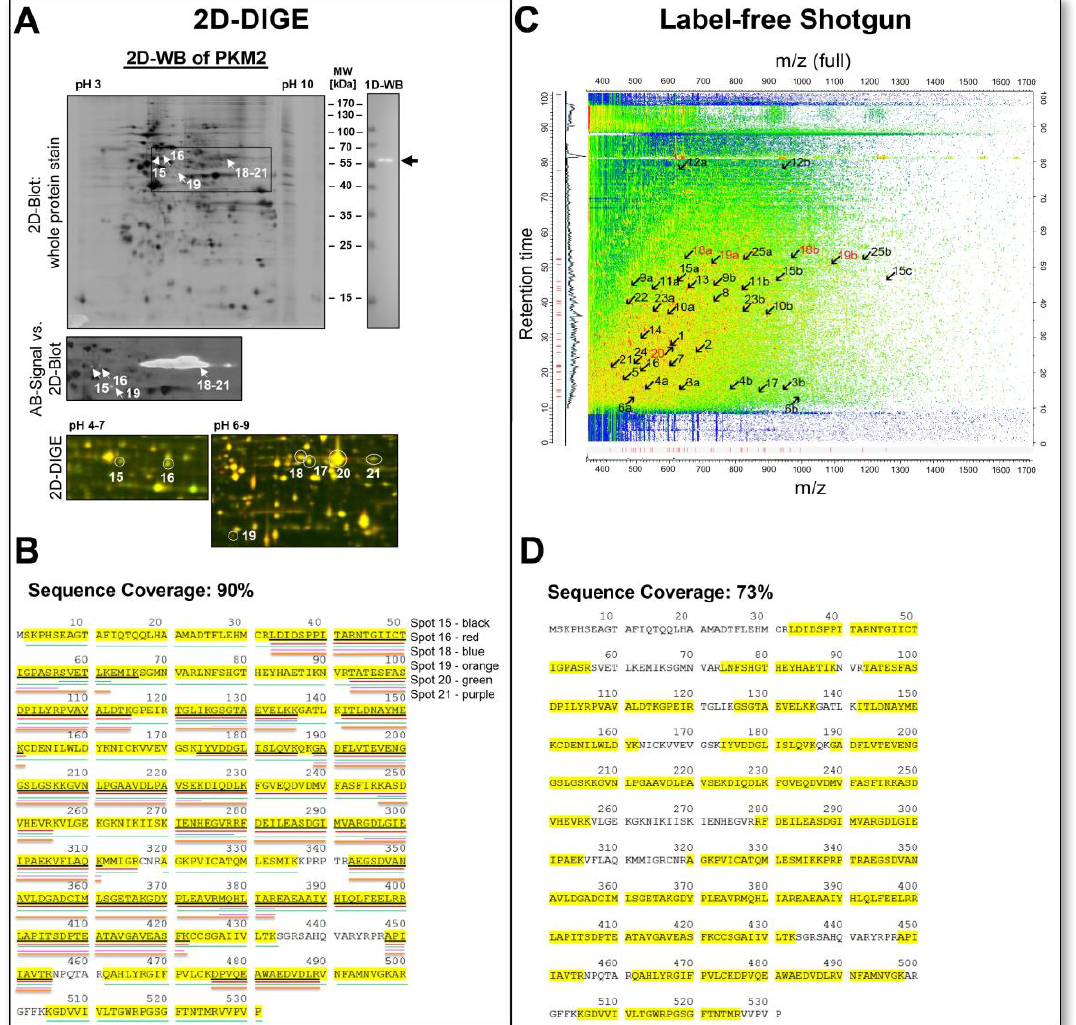
Figure 7. An unbiased proteoform exploration is only feasible with 2D-DIGE, as exemplified on PKM2. ( A ) PKM2-proteoform identification with 2D-DIGE: 30 µ g Cy5-labeled DU145 protein was applied to IEF on a 7 cm pH 3–10 IPG-strip followed by 11.5% SDS-PAGE and blotted onto a PVDF membrane. The blotted Cy5 labeled proteins on the membrane were scanned with a laser scanner at 650 nm wavelength and shown as black spots. Afterwards, the blotted Cy5-labeled DU145 sample membrane is incubated with antibodies against PKM2 antibody (first left image). The specific signals are visualised by secondary HRP-conjugated antibodies and chemiluminescence and are shown as white spots. One-dimensional WB shows the PKM2 signal (white band) as the sum in a single band (right image). Overlay of Cy5-labelled protein spots (black spots) vs. PKM2 2D-WB signals (white spots), obtained through the Online Image Editor (https://www.online-image-editor.com, accessed on 25 July 2022). 2D-DIGE image shows the positions of different PKM2 proteoforms in the pH range 4–7 and pH range 6–9. The PKM2 spots are circled, and the spot number match those listed in Table 1. ( B ) Sequence coverage of PKM2 in 2D-DIGE/MS analysis. Yellow boxes represent the position of identified peptides in the protein sequence. ( C ) Representative centroid-peak view of all identified tryptic peptides and specific peptides assigned to PKM2. Proteotypic peptides are indicated in red. ( D ) Sequence coverage achieved by shotgun. Yellow boxes represent the position of identified peptides in the protein sequence. Abbreviations: 2D-DIGE—two-dimensional difference gel electrophoresis; MW—molecular weight; IEF—isoelectric focusing; IPG—immobilised pH gradient; WB—western